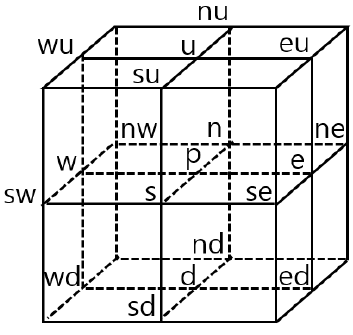
Figure 2. Adjacencies in a 3D binary array.